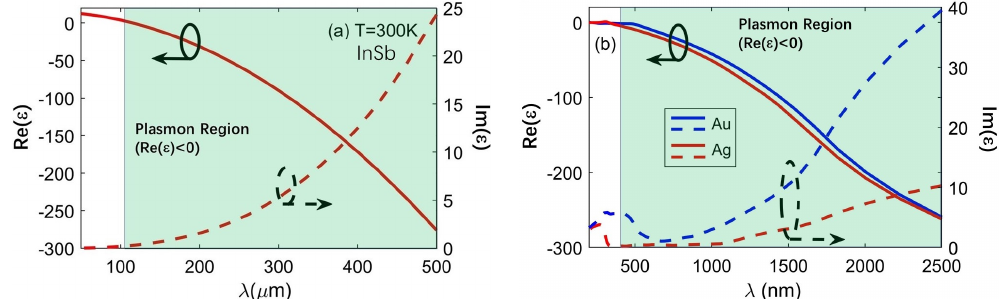
Figure 9. Dependence of real and imaginary parts of permittivity on the wavelength for ( a ) InSb at THz frequencies and ( b ) noble metals (i.e., Au and Ag) at optical frequencies. Light green areas represent cases of Re( ε ) < 0.